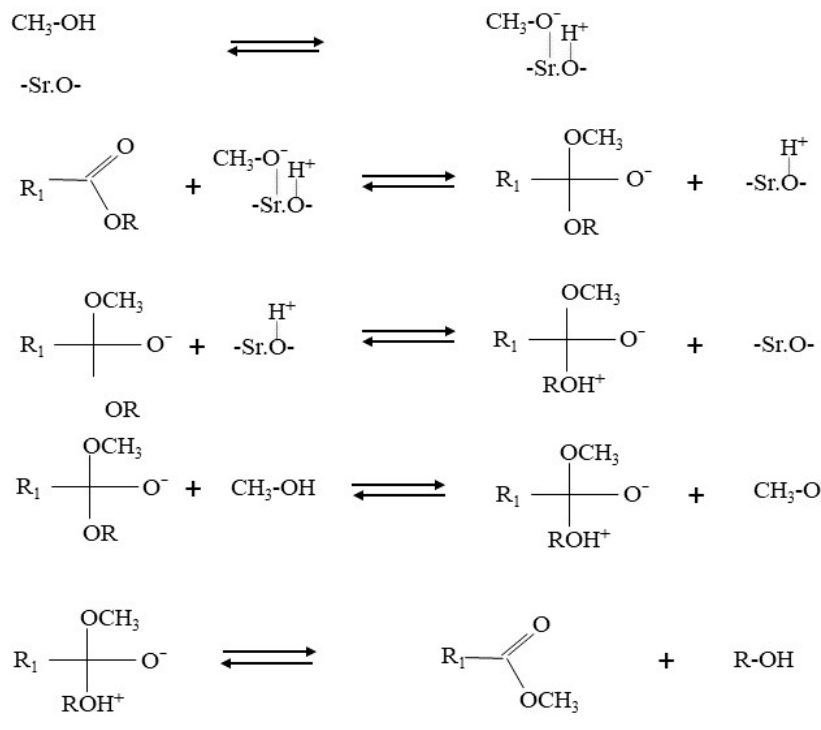
Figure 7. Mechanism of SrO catalyst transesterification.